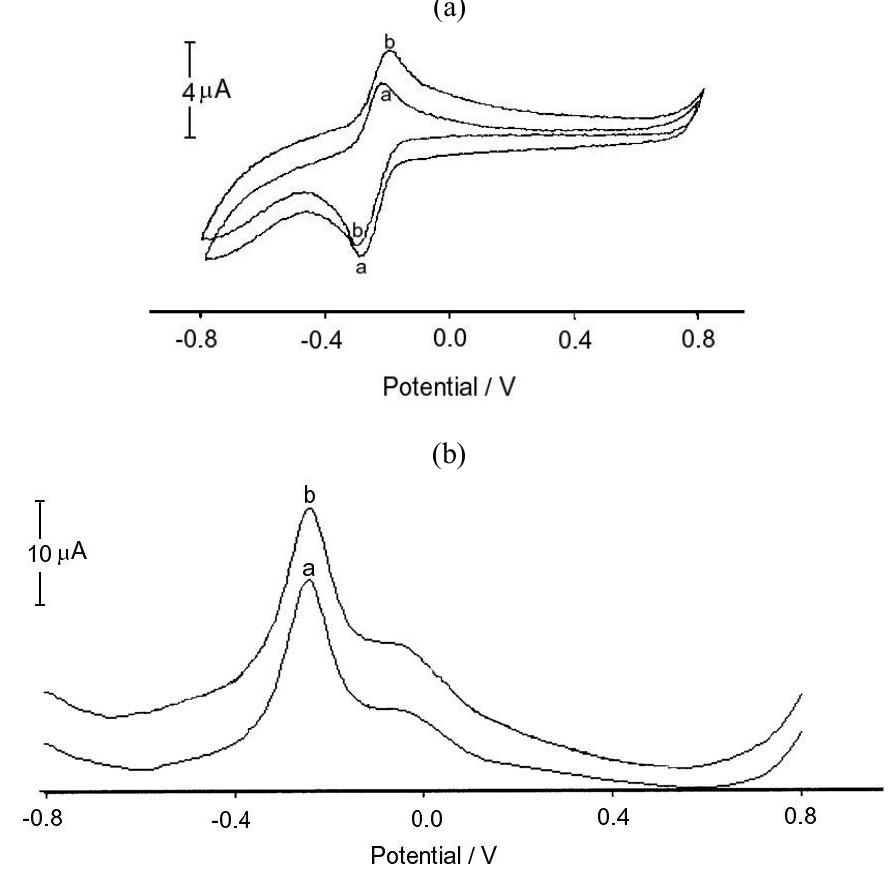
Figure 1 . (a): Cyclic voltammograms obtained for a cellulose acetate modified with TBO glassy carbon electrode (a) in the absence of NADH and (b) in the presence of 1 mM NADH, in 50 mM phosphate buffer pH 7.0; scan rate 15 mV/s; (b): Differantial pulse voltammograms obtained for a cellulose acetate modified with TBO glassy carbon electrode (a) in the absence of NADH and (b) in the presence of 1 mM NADH, in 50 mM phosphate buffer pH 7.0; scan rate 15